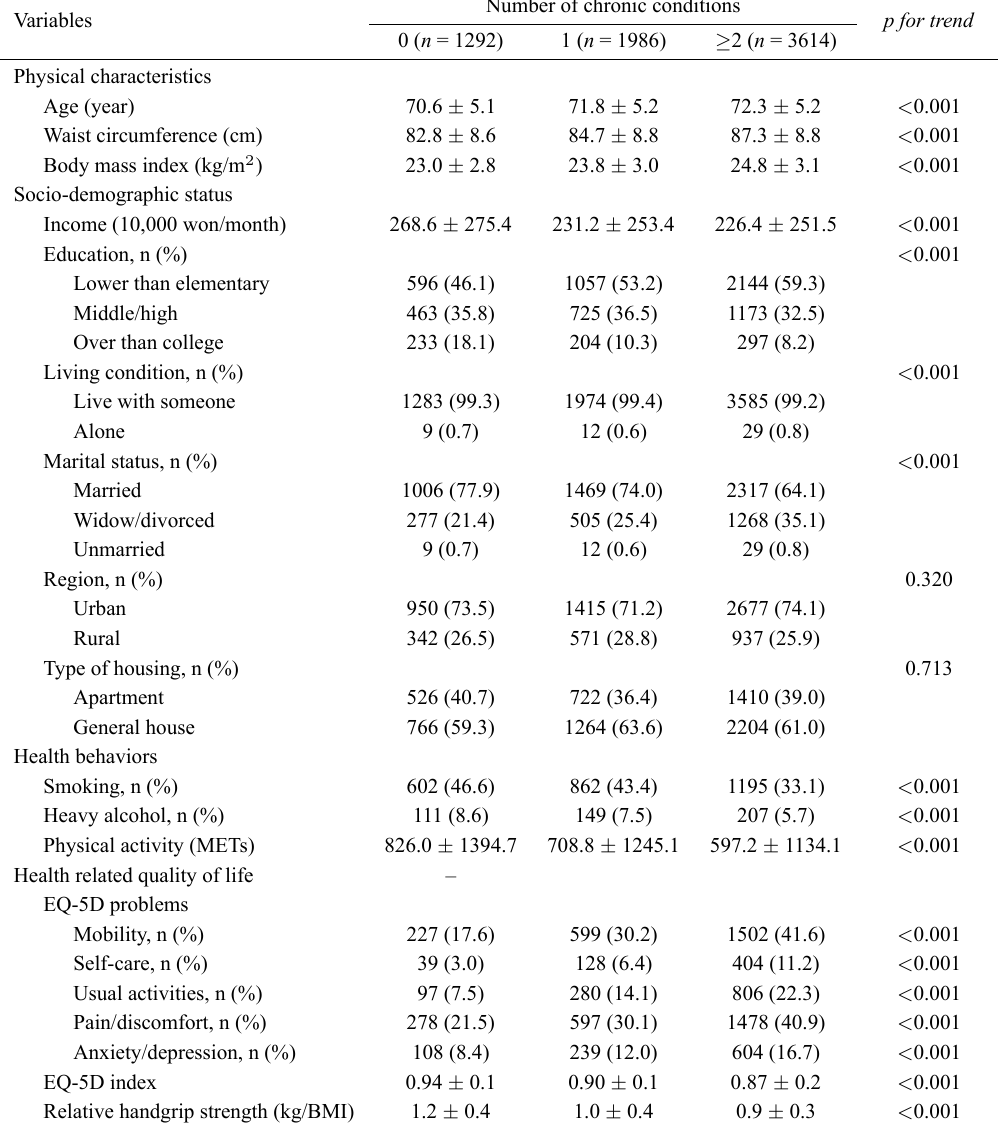
Table 2. Comparison of measurement variables according to number of chronic conditions (Mean ± SD).